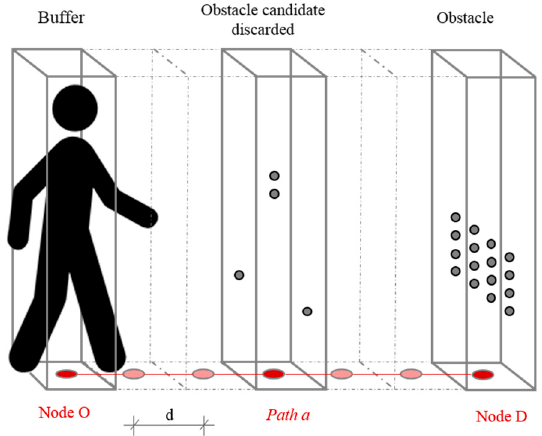
Figure 4. Schema of the obstacle detection strategy (adapted from [35]).